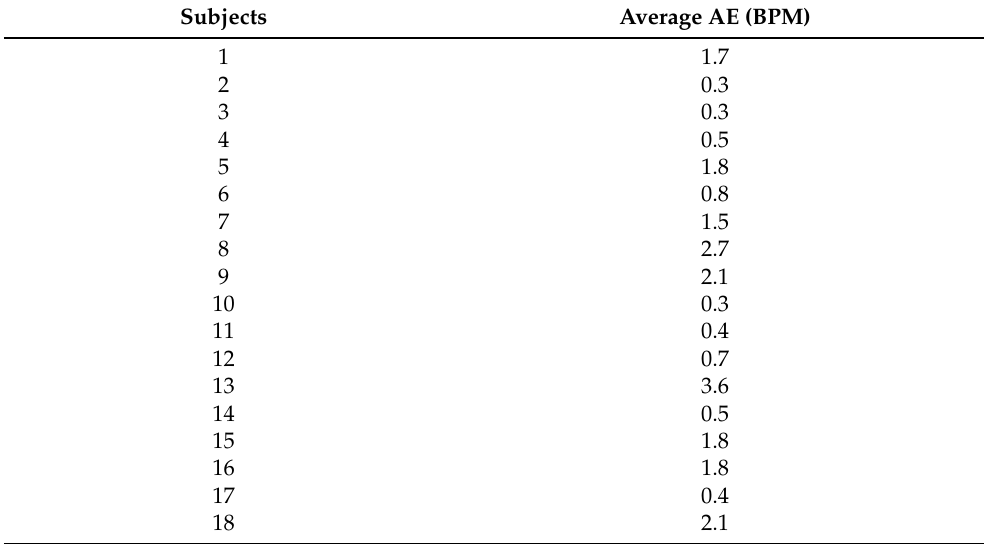
Figure 8. An example of the filtered O 2 Hb signal, the corresponding baseline wanders, and the reference respiratory signal. Table 3. The average of AE between the reference and estimated RRs for each subject of dataset